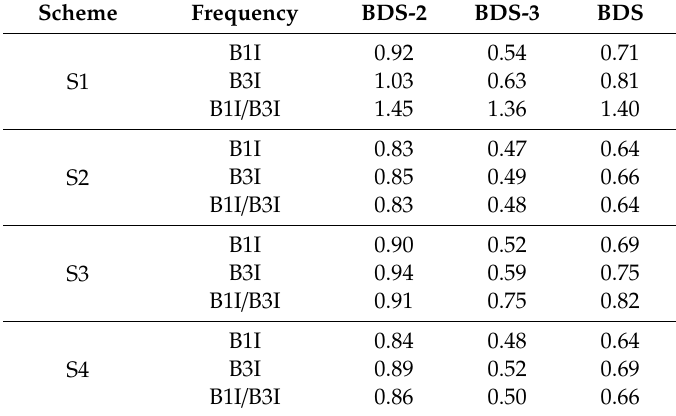
Table 7. BDS signal-in-space range error (SISRE) performance for di ff erent schemes (in meters). S1: Normal satellite TGD correction. S2: Use of the satellite-dependent TGD bias calibrated from precise products. S3: Use of the TGD bias between BDS-2 and BDS-3 calibrated from precise products. S4: Use of the satellite-dependent TGD bias calibrated from network solution. Scheme